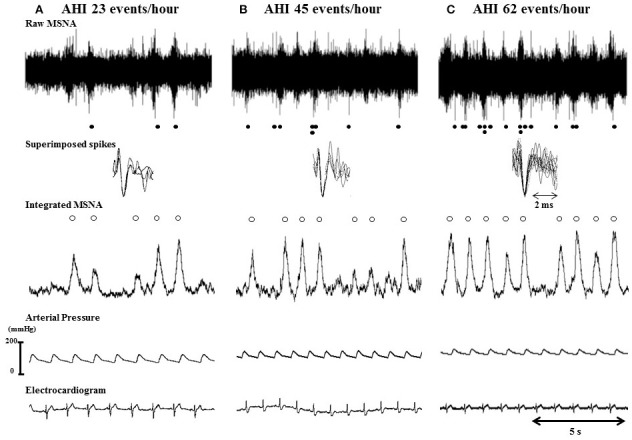
Typical recordings of single- and multi-unit MSNA in three OSAS patients separated by OSAS severity (AHI). (A–C) Show traces of single- and multi-unit MSNA in an OSAS patient with an AHI of 5–30 events/h, a severe OSAS patient (AHI of 30–55 events/h), and a very severe OSAS patient (AHI of >55 events/h), respectively. White circles indicate multi-unit MSNAs, and black circles indicate single-unit MSNAs. Single-unit MSNAs were confirmed by superimposing the action potentials.